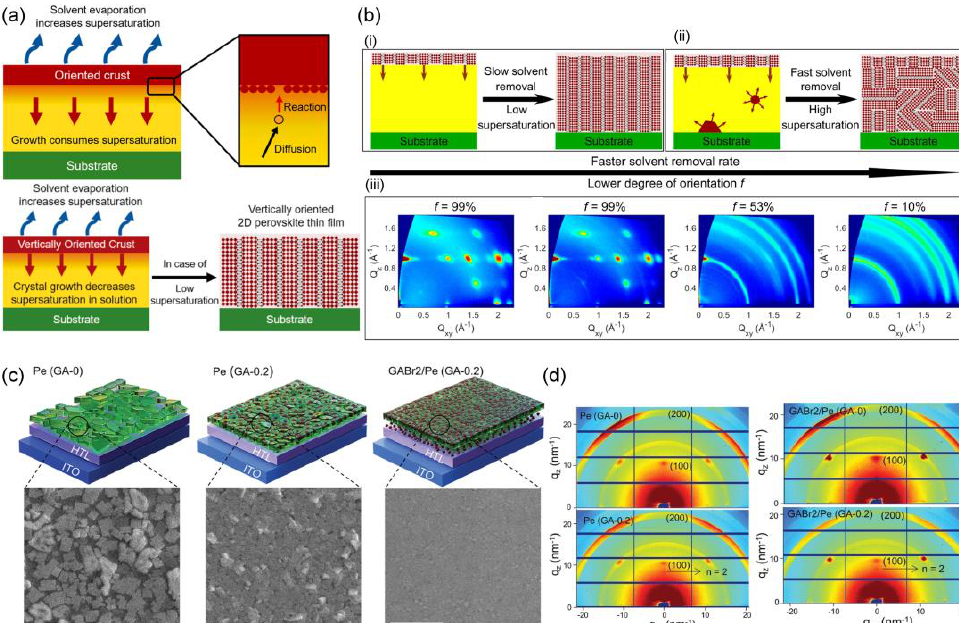
Figure 8. Heterogeneous nucleation of quasi-2D perovskites. ( a ) Schematic diagram of supersaturation process indicating fast solvent evaporation and formation of vertically oriented 2D perovskite. ( b ) ( i ) At lower supersaturation, continuity of crystal growth with slow removal rate of solvent of vertically oriented 2D perovskite (not to scale); ( ii ) introduction of orientation randomness with fast solvent evaporation; ( iii ) GIWAXS patterns with increasing solvent removal rate, including slow, medium, fast, and fastest, accordingly [126]. ( c ) Schematic illustration of doping effect of GABr on HTL with corresponding SEM images (scale bars are 500 nm). ( d ) GIWAXS patterns for different doping concentrations of GABr show different peak positions (red color) along the q z axis, indicating that the layered perovskites are aligned horizontally to the substrate [128]. Reprinted with permission.